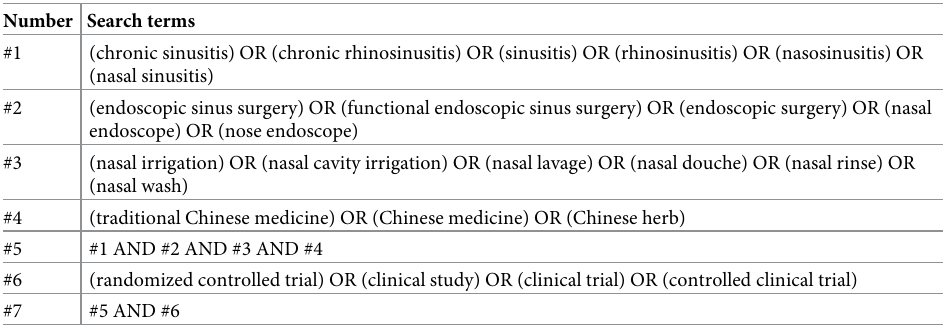
Table 1. Search strategy for